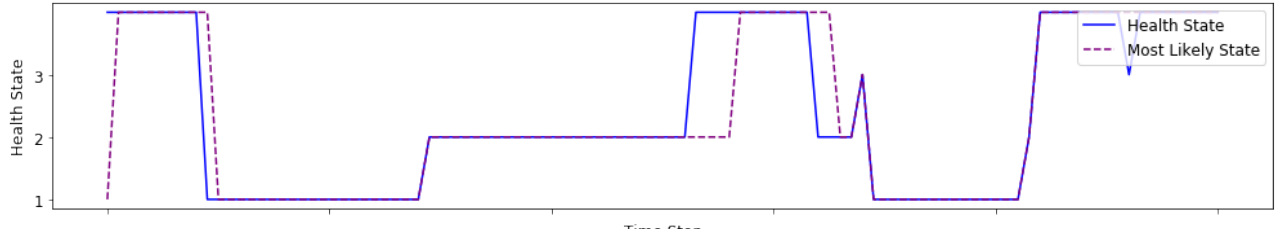
Figure 8. The unknown health state and the most likely health state (using the greedy policy) over 20 epochs.